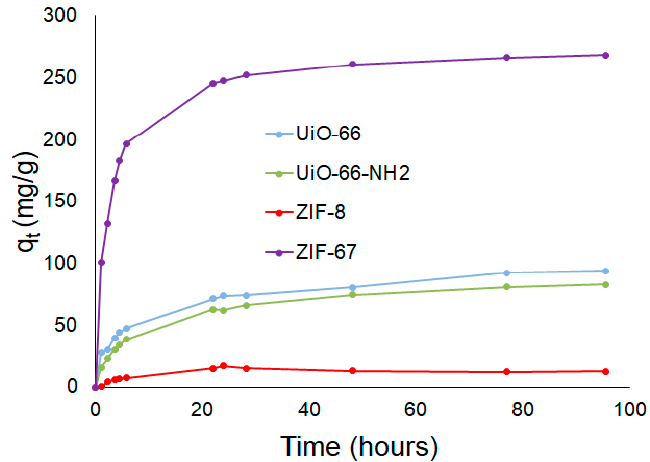
Figure 4. Adsorption capacity of AO7 in UiO-66, UiO-66-NH 2 , ZIF-8, and ZIF-67 as a function of time.